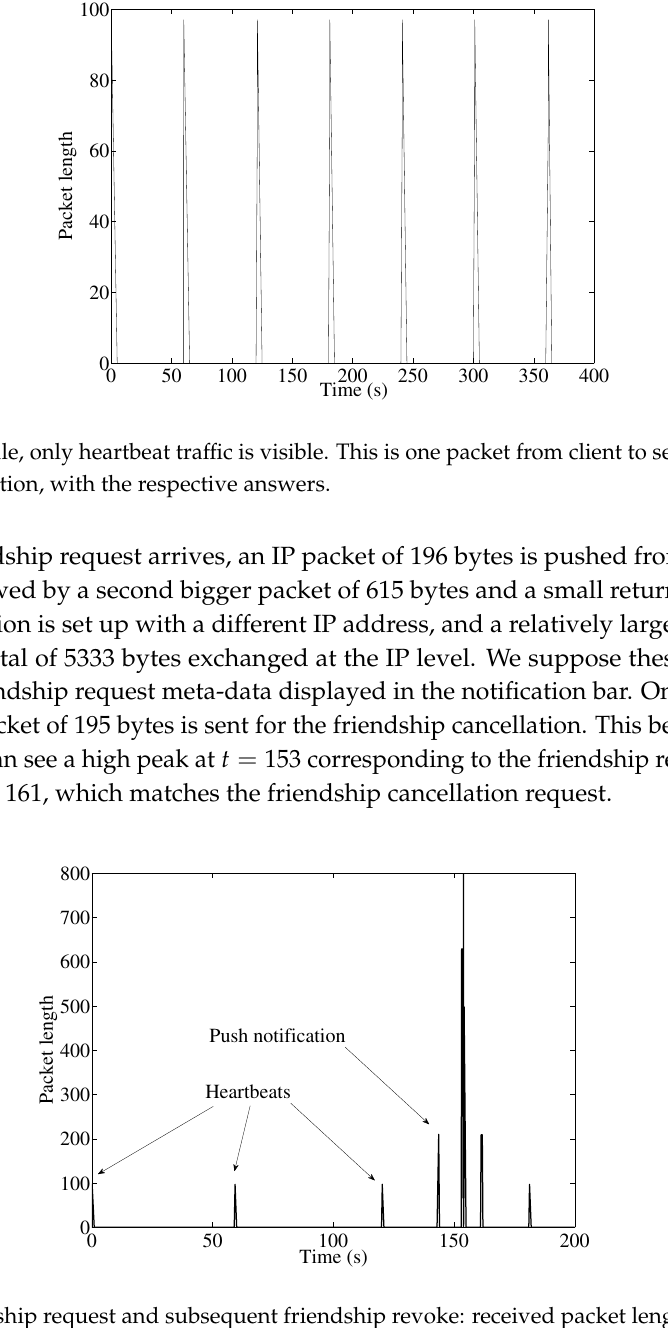
Figure 4. Friendship request and subsequent friendship revoke: received packet lengths over